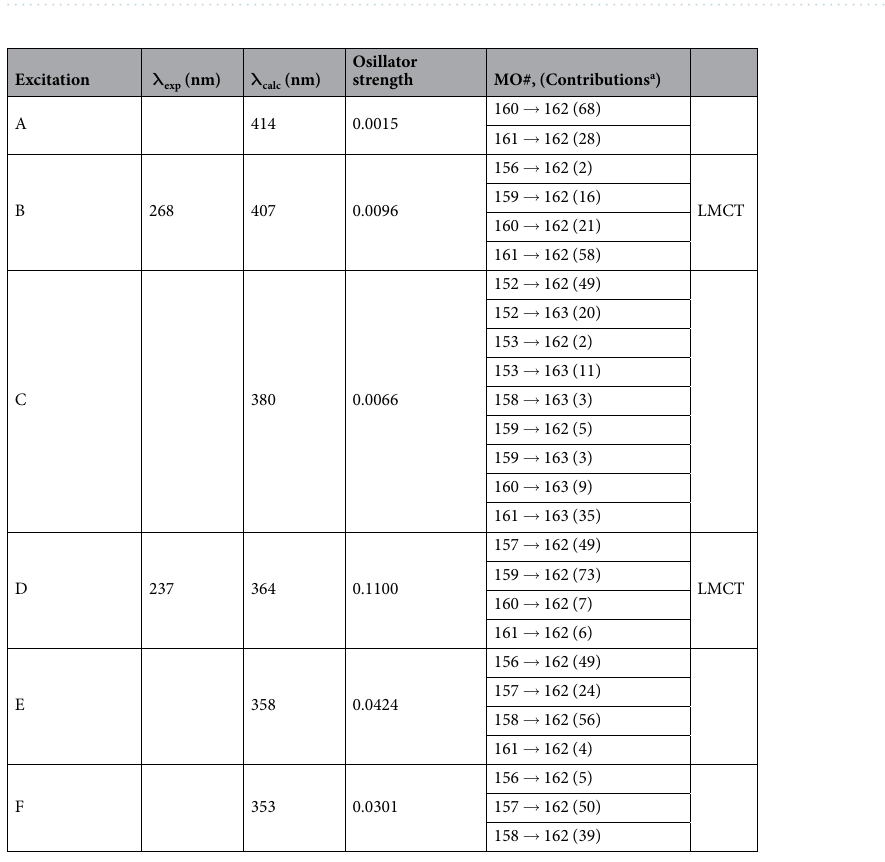
Table 1. TD-DFT Excitation Calculations for 6 . a Value is 2 × (coeff) 2 ×